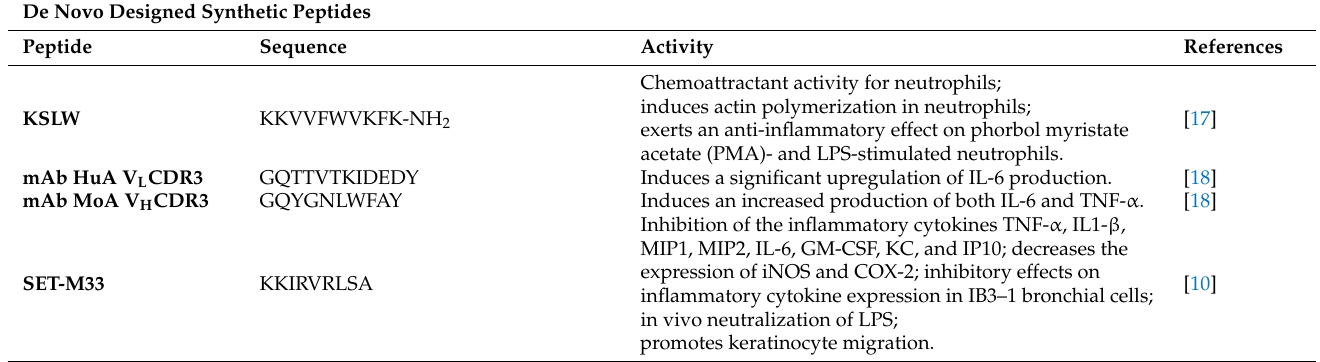
Table 3. Selected peptides and peptide derivatives with proven immunomodulatory